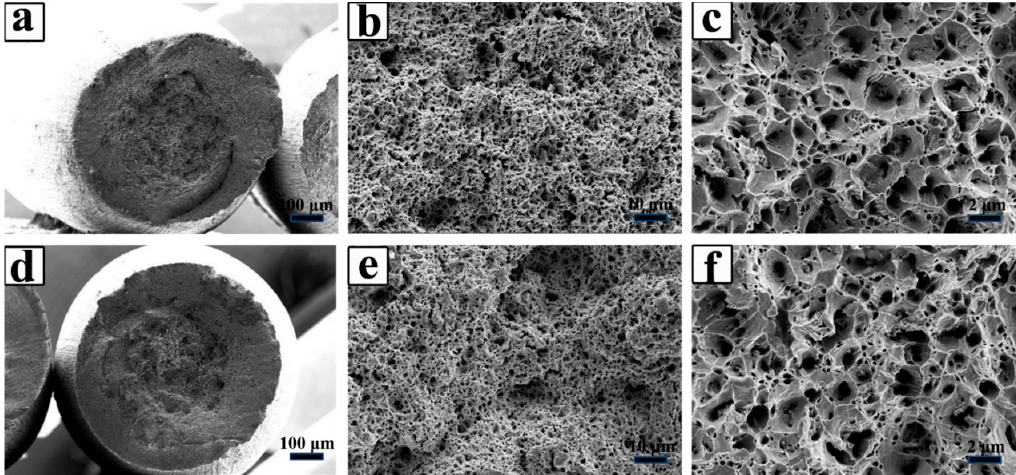
Figure 5. Scanning electron microscopy (SEM) image of tensile fracture morphology of Q195 carbon structural steel. ( a – c ) Before EPP; ( d – f ) With 25 s EPP treatment.